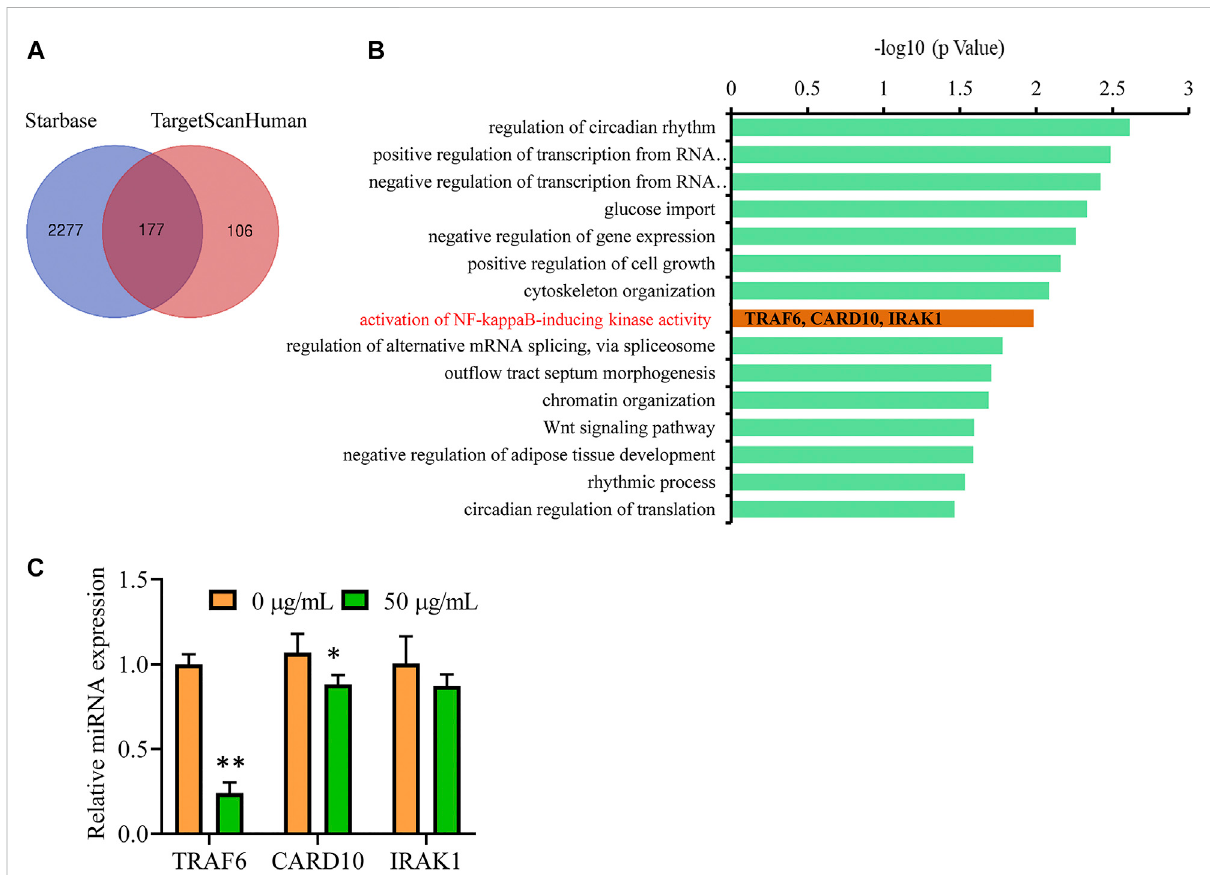
FIGURE 7 TRAF6 isa potential targetgene of miR-146b-5p to suppress in fl ammation response. (A) Venn diagram displaying thenumbers ofthe common targetgenesofhsa-miR-146b-5pinStarbaseandTargetScanHumandatabases. (B) Thegeneontologyenrichmentofthe177candidates.TheY-axis lists thename ofeach category,and theX-axisshowsthe-log10 values ( p -value). (C) U87 cells weretreated with GBE (0 and 50 µg/ml) for 24 h, and the expression of CARD10, IRAK1, and TRAF6 were detected using qPCR. * p < 0.05, ** p < 0.01 vs. vehicle